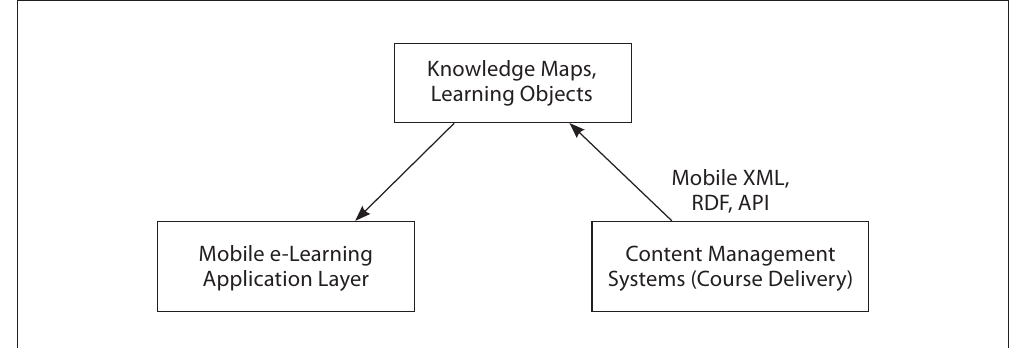
Figure 1 Roadmap of K-Map and learning objects in mobile